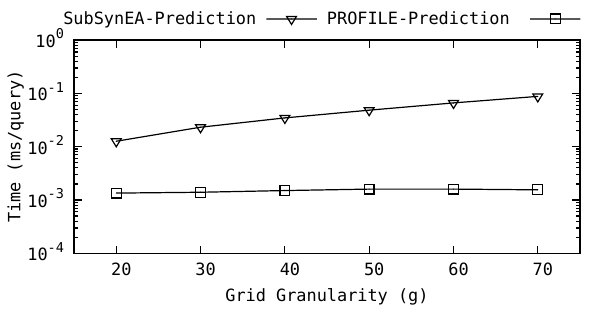
Figure 3. Runtime Efficiency of Prediction Algorithms